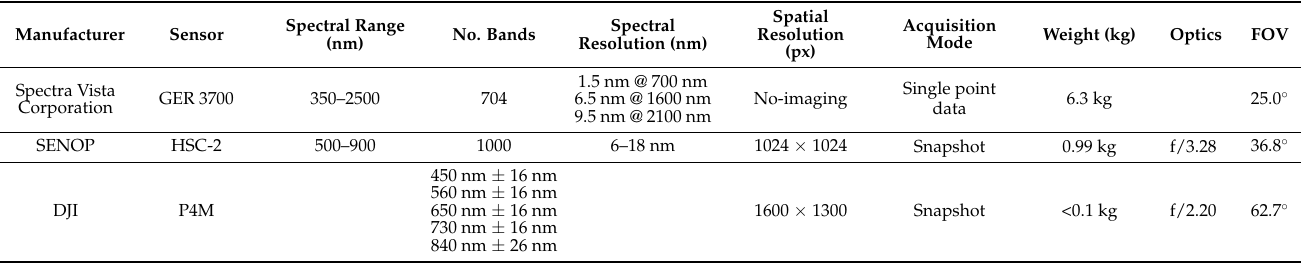
Table 1. Sensors technical